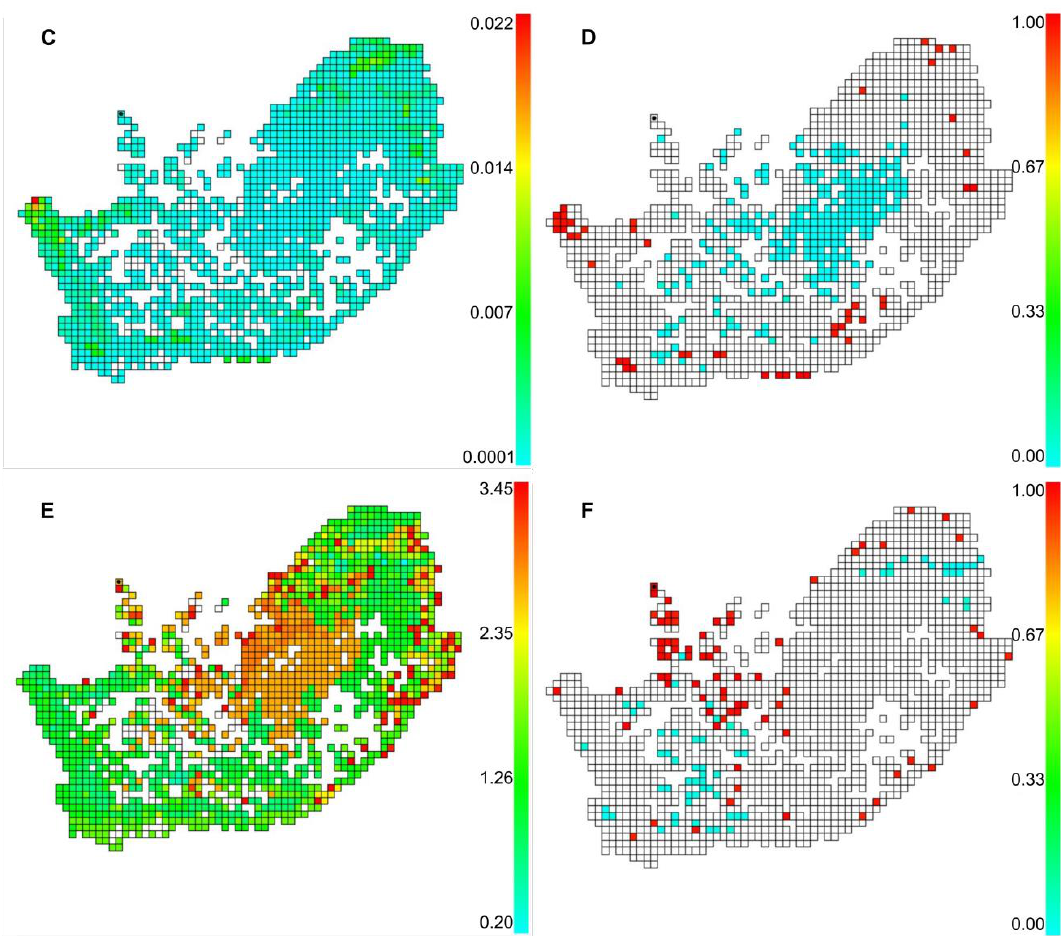
Figure 5. Maps of various diversity and endemism indices: ( A ) Weighted Endemism (WE), ( B ) Cor- rected Weighted Endemism (CWE), ( C ) Phylogenetic Endemism (PE), and ( E ) Relative Phylogenetic Endemism (RPE). Maps showing significance levels resulting from a randomization test for ( D ) PE and ( F ) RPE. The red values indicate grid cells that contain significantly less PE/RPE than expected; the blue values indicate grid cells that contain significantly more PE/RPE than expected.